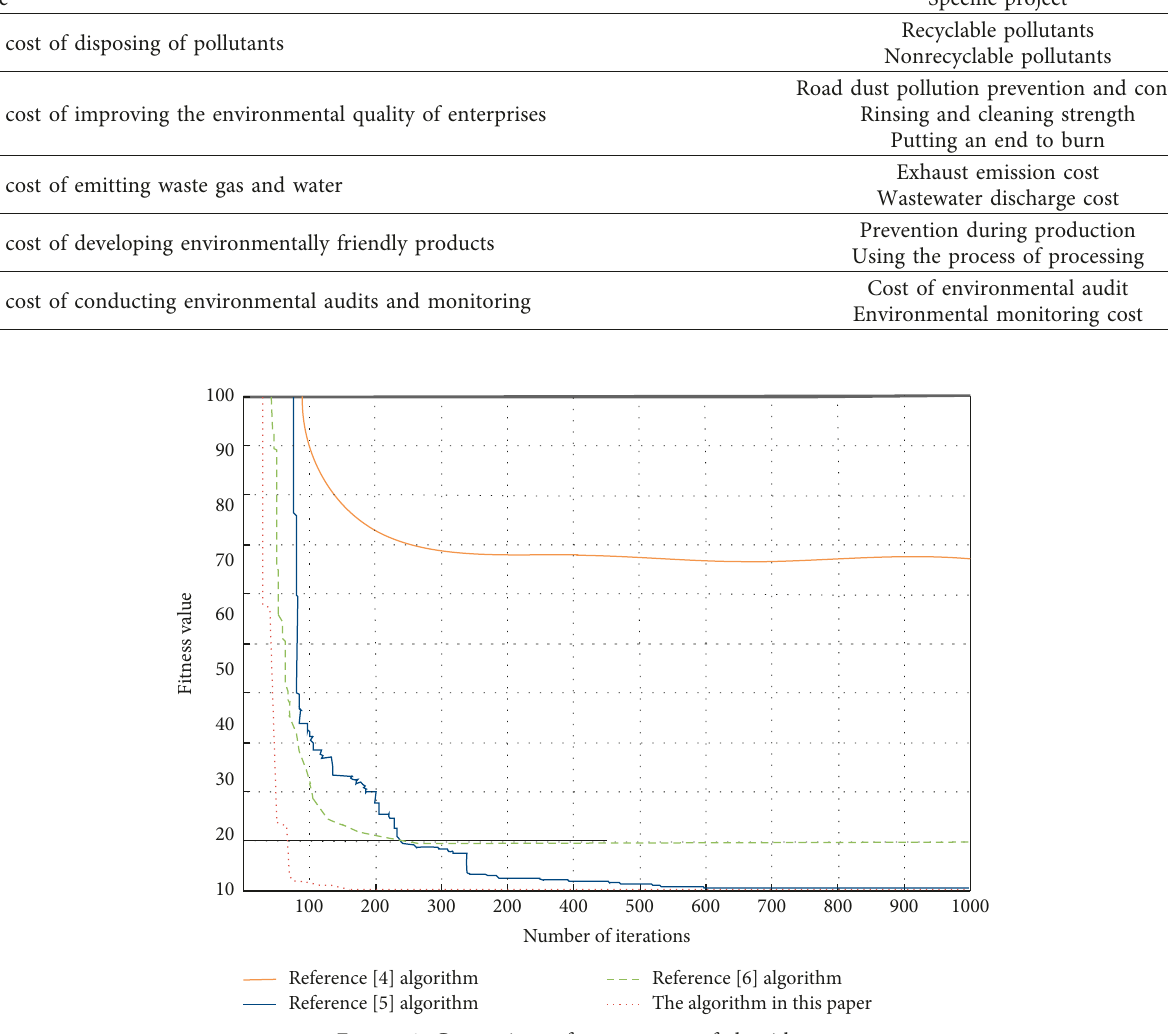
Figure 2: Comparison of convergence of